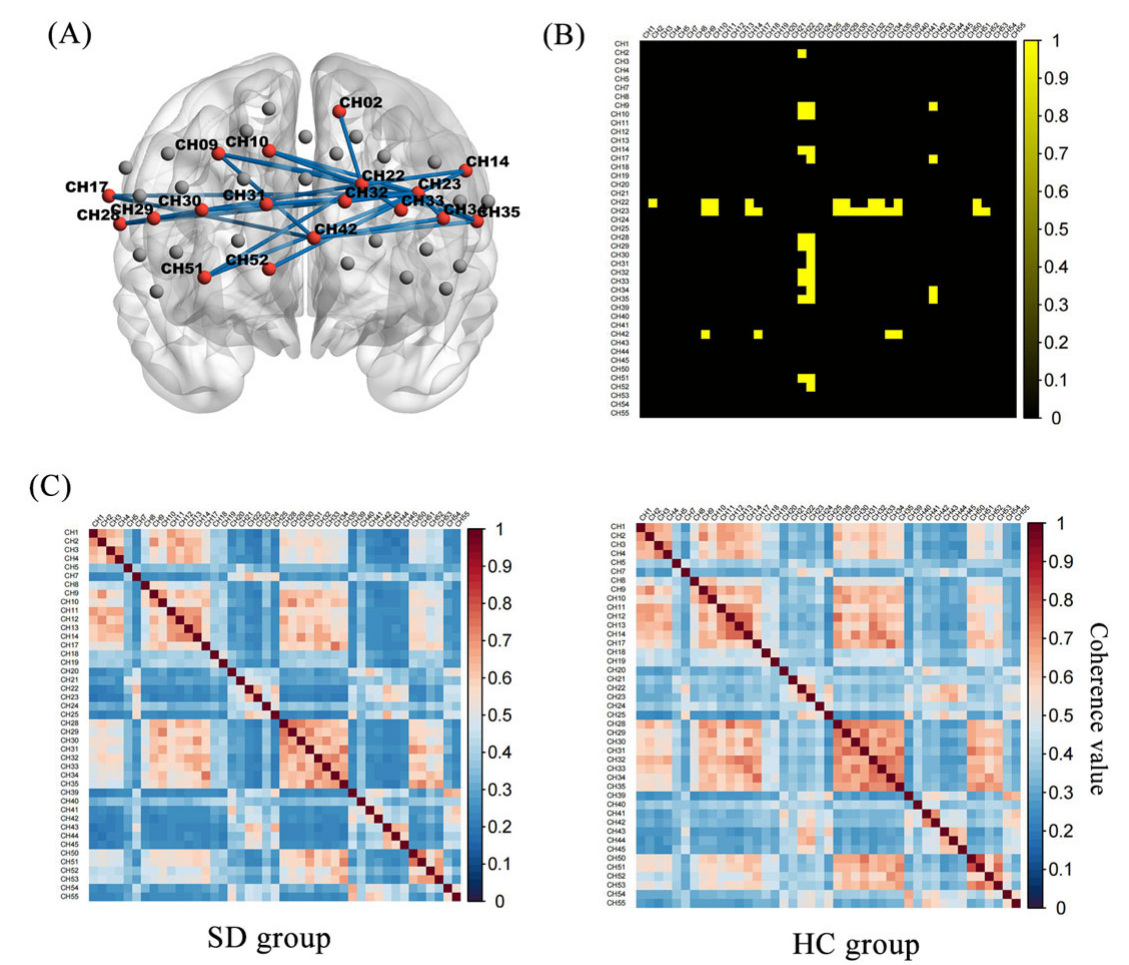
Figure 4. Functional connectivity matrix in the HC and SD: ( A ) Twenty-eight pairs had significantly higher channel-to-channel connectivity in the HC group than in the SD group. ( B ) The group- difference of channel-to-channel connectivity strength in binary matrices, where the yellow part is the significant difference part ( C ). Functional connection strength between the respective channel-to- channel of the SD and HC.